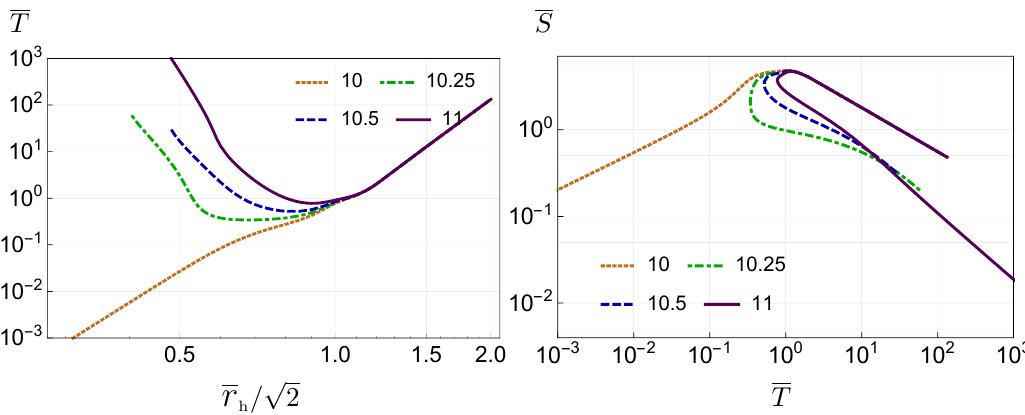
Figure 24. (Left) Temperature as a function of the horizon radius. (Right) Entropy as a function of the temperature.